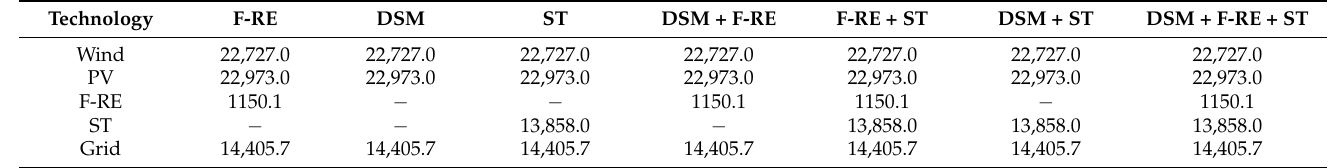
Table A12. Installed capacity in kW of balancing technologies scenarios.